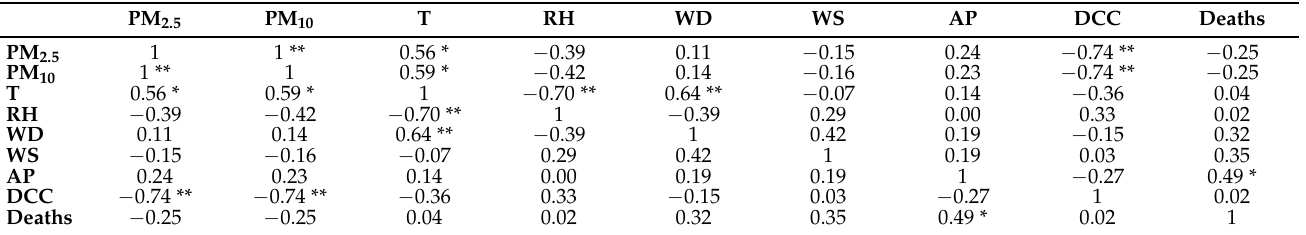
Table 4. Spearman correlation coefficient matrix using the outdoor pollution and meteorological factors dataset.